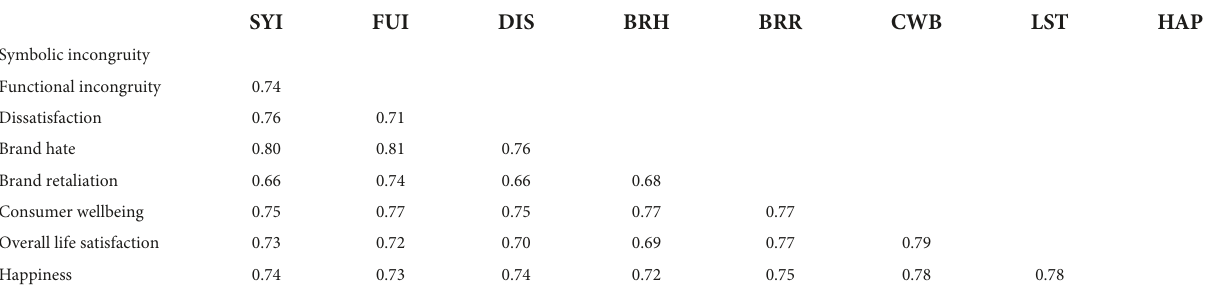
TABLE 3 Discriminant validity/HTMT